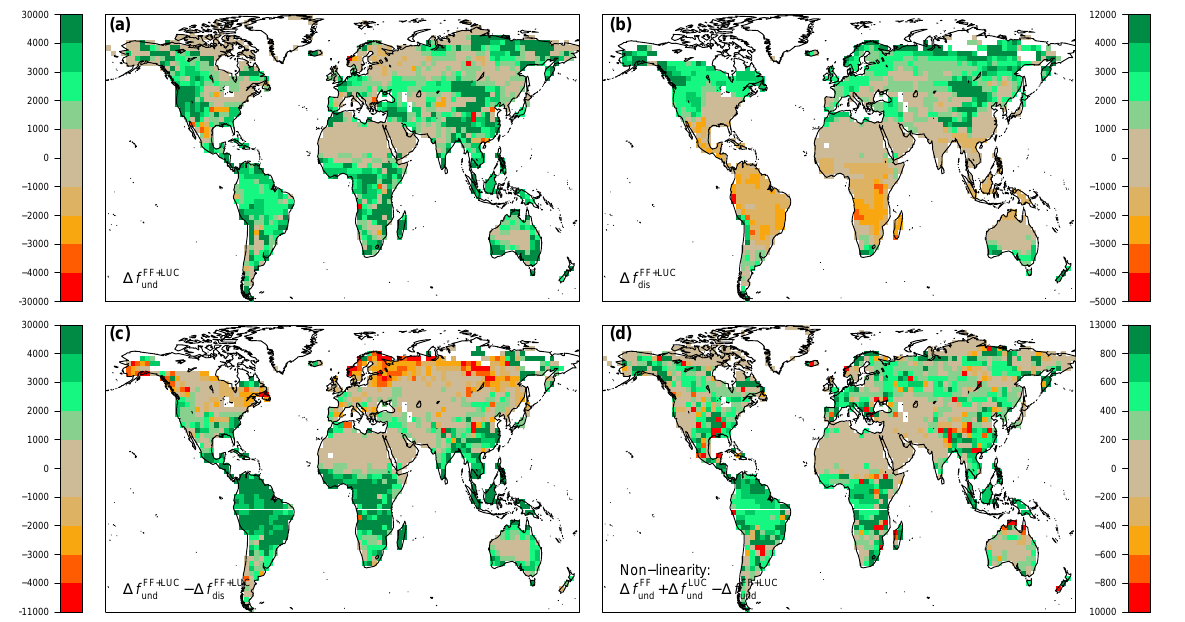
Figure 4. Top row panels: cumulative atmosphere-land C flux (kgCm − 2 ) induced by environmental change from 1700 to 2100 on undis- turbed (a) and disturbed land ( b ; mean of cropland and pasture, weighted by respective area shares). Here, “disturbed” is approximated by cropland and pasture area (small at 1700), and “undisturbed” by natural area. The period 2005–2100 follows the RCP8.5 scenario. Climate and CO 2 are prescribed from the outputs of the coupled simulation (offline simulation F FF + LUC ence of flux occurring on undisturbed and disturbed land f FF + LUC year 2100. Its global total over time is expressed also in Fig. 1 (difference between black and red